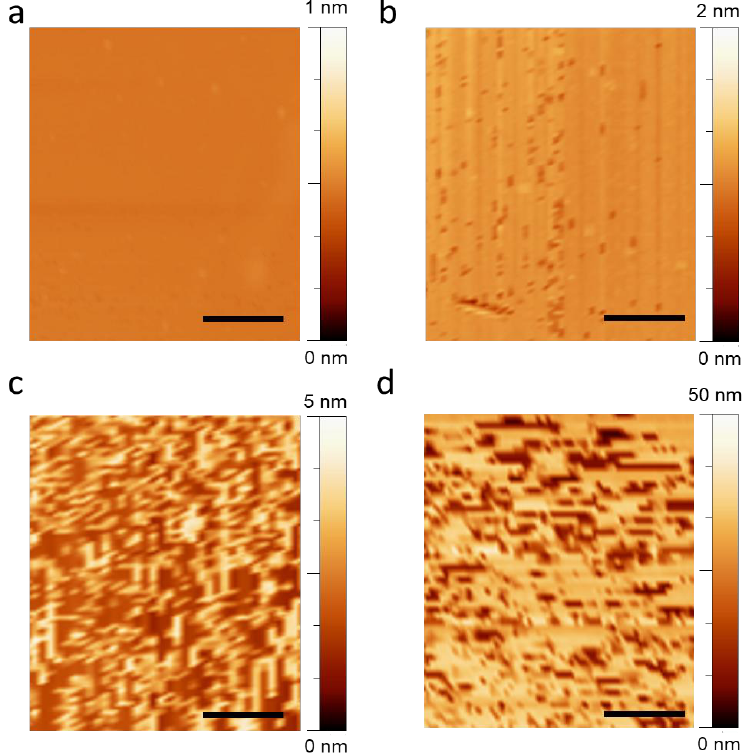
Figure 3. The atomic force microscopic image of our graphene channel substrate after functionalizing using PLB construct at increasing concentrations. ( a ) The AFM image of graphene surface containing 0.001 nM PLB construct for functionalization. ( b – d ) The AFM image of graphene-channel-based substrate with 1 nM, 100 nM, and 1000 nM PLB, respectively. The inset scale bar in each figure is equivalent to 2 µm.